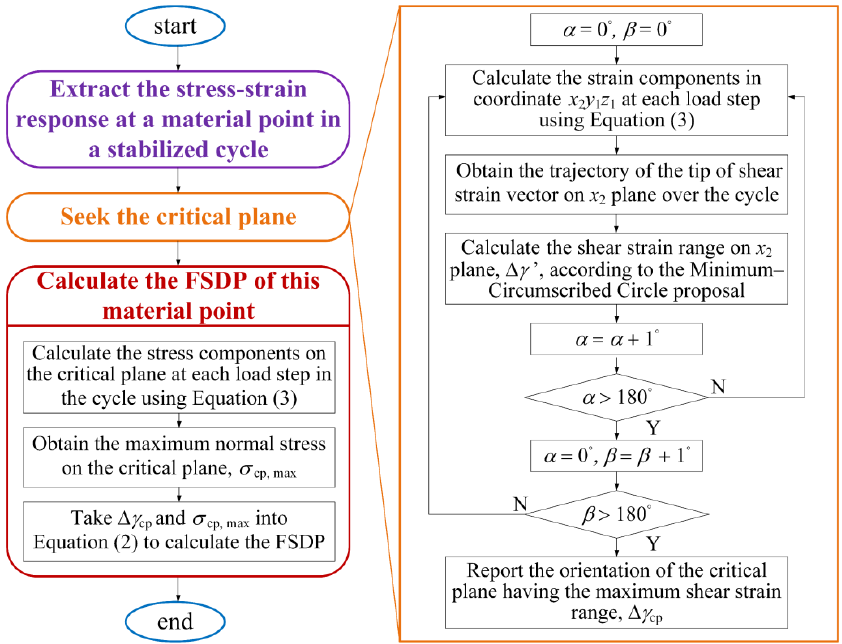
Figure 3. The numerical procedure to determine the critical plane and Fatemi–Socie damage parameter (FSDP) of a material point.